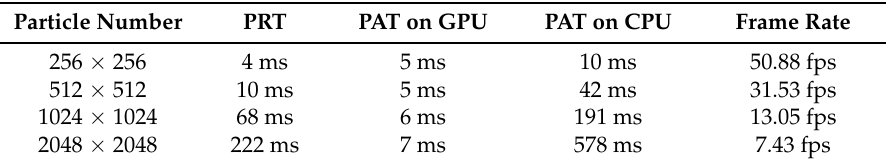
Figure 9. Time consumption of particle advection with different particle number. Table 1. Performance test (particle render time consumption, particle advection time consumption, frame rate) with different particle numbers. Particle Number